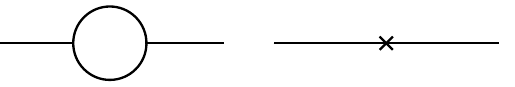
Figure 2 . (Left) Connected one-loop contribution to the two-point correlation function in a λφ 3 theory. (Right) The corresponding δ m and/or δ r counterterm